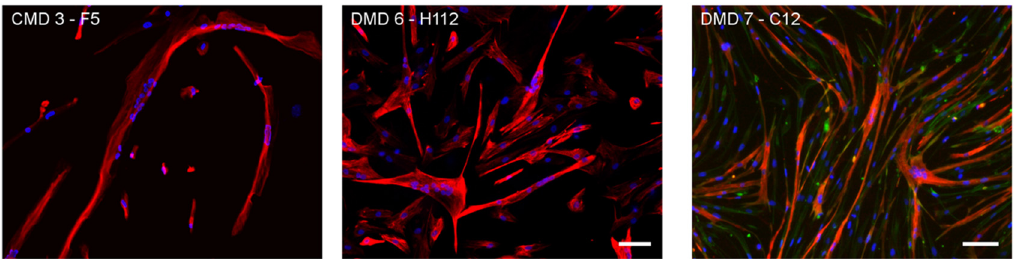
Figure 3. Myogenic di ff erentiation of iHMuSC clones. Clones selected for their good growth capacity were tested for their myogenic di ff erentiation capacity. In the 2D glass condition (left and middle panels), clones were di ff erentiated on glass culture supports for 5 days before the detection of desmin (red) using immunofluorescence. In the 3D-Matrigel condition (right panel), clones were di ff erentiated between 2 thin Matrigel coats for 5 days before the detection of actin (green) and MHC (red) using immunofluorescence. Nuclei are labelled with Hoechst (blue). Bars = 100 µ m.